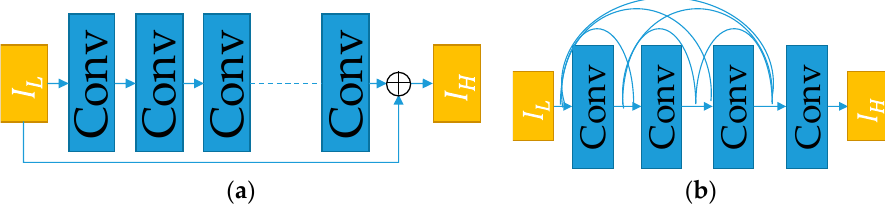
Figure 1. Simplified structures of ( a ) VDSR and ( b ) SRDenseNet. The first strategy, ( a ) VDSR, uses a deeper CNN model to enlarge the receptive fields and improve the representation power. The second strategy, ( b ) SRDenseNet, reuses the features from shallow layers. Due to the different scale of objects in images, hierarchical features from a very deep network would provide more additional information to reconstruct the HR images.